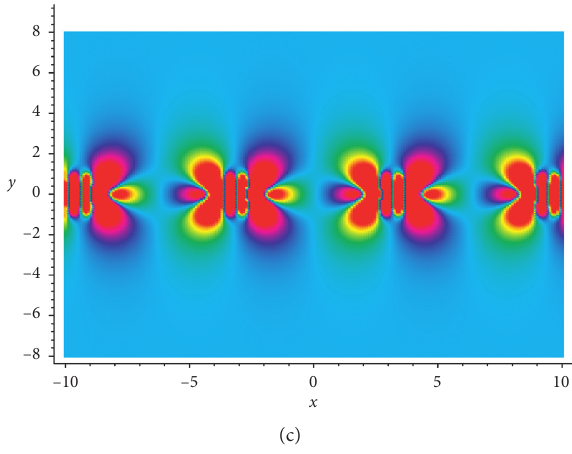
Figure 6: The x -periodic symmetry breaking density plot of the second-order breathers of the AB-KP systems (7a) and (7b), with the selected parameters b